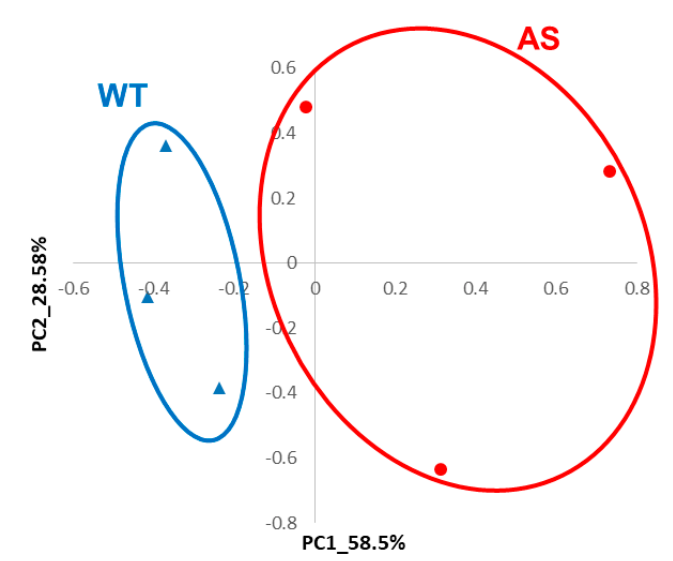
Figure 8. Random forest analysis of gene expression data from the hippocampi of Angelman syndrome (AS) model mice and their control littermates identified 40 apoptosis-related and 10 proliferation-related genes as markers of the AS hippocampi. Principal component analysis (PCA) of these 50 genes identified by random forest analysis. First two PCs clearly separate the AS and the wild-type (WT) samples ( n = 3 per group) as predicted by random forest.